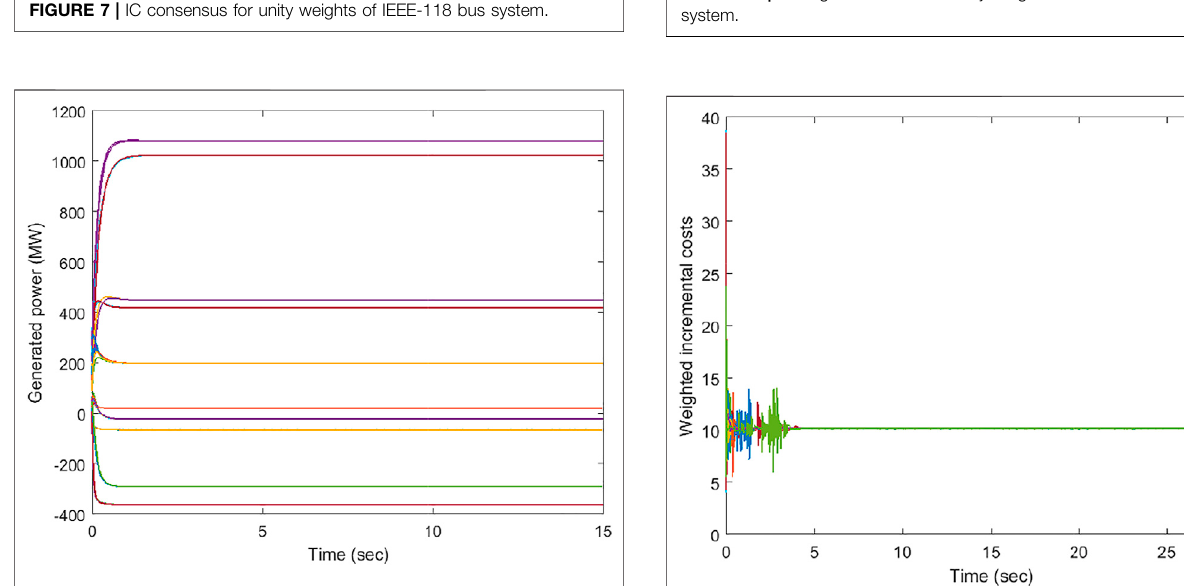
FIGURE 10 | Weighted IC consensus using the proposed approach for IEEE-118 bus